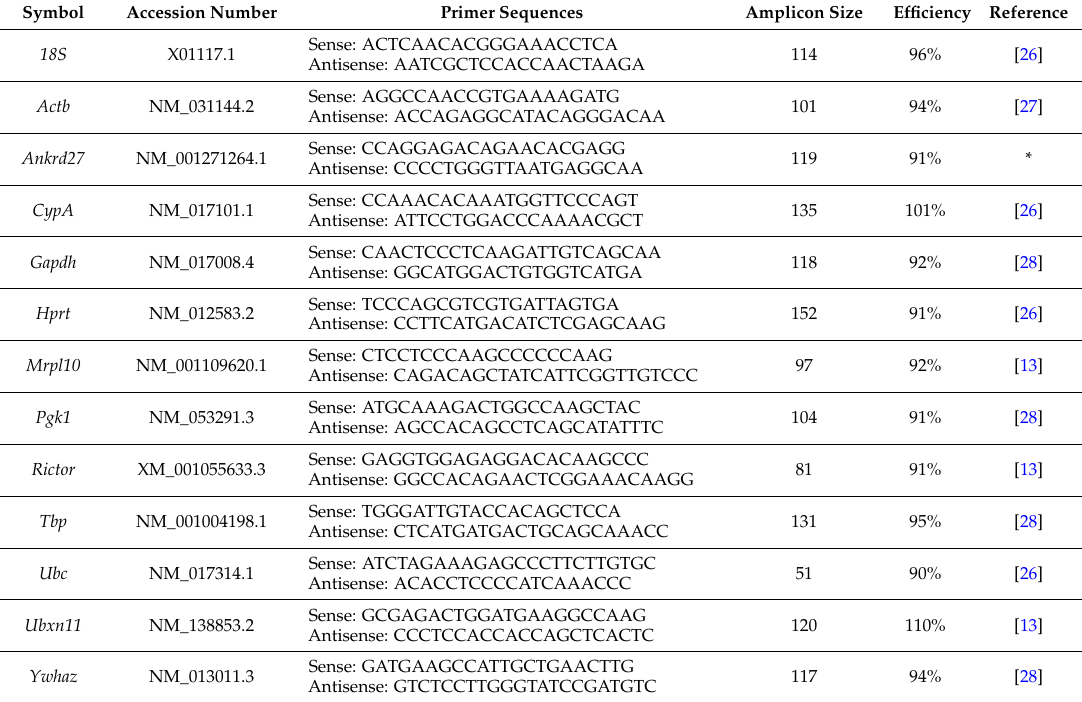
Table 5. Primer sequences of candidate housekeeping genes evaluated in this